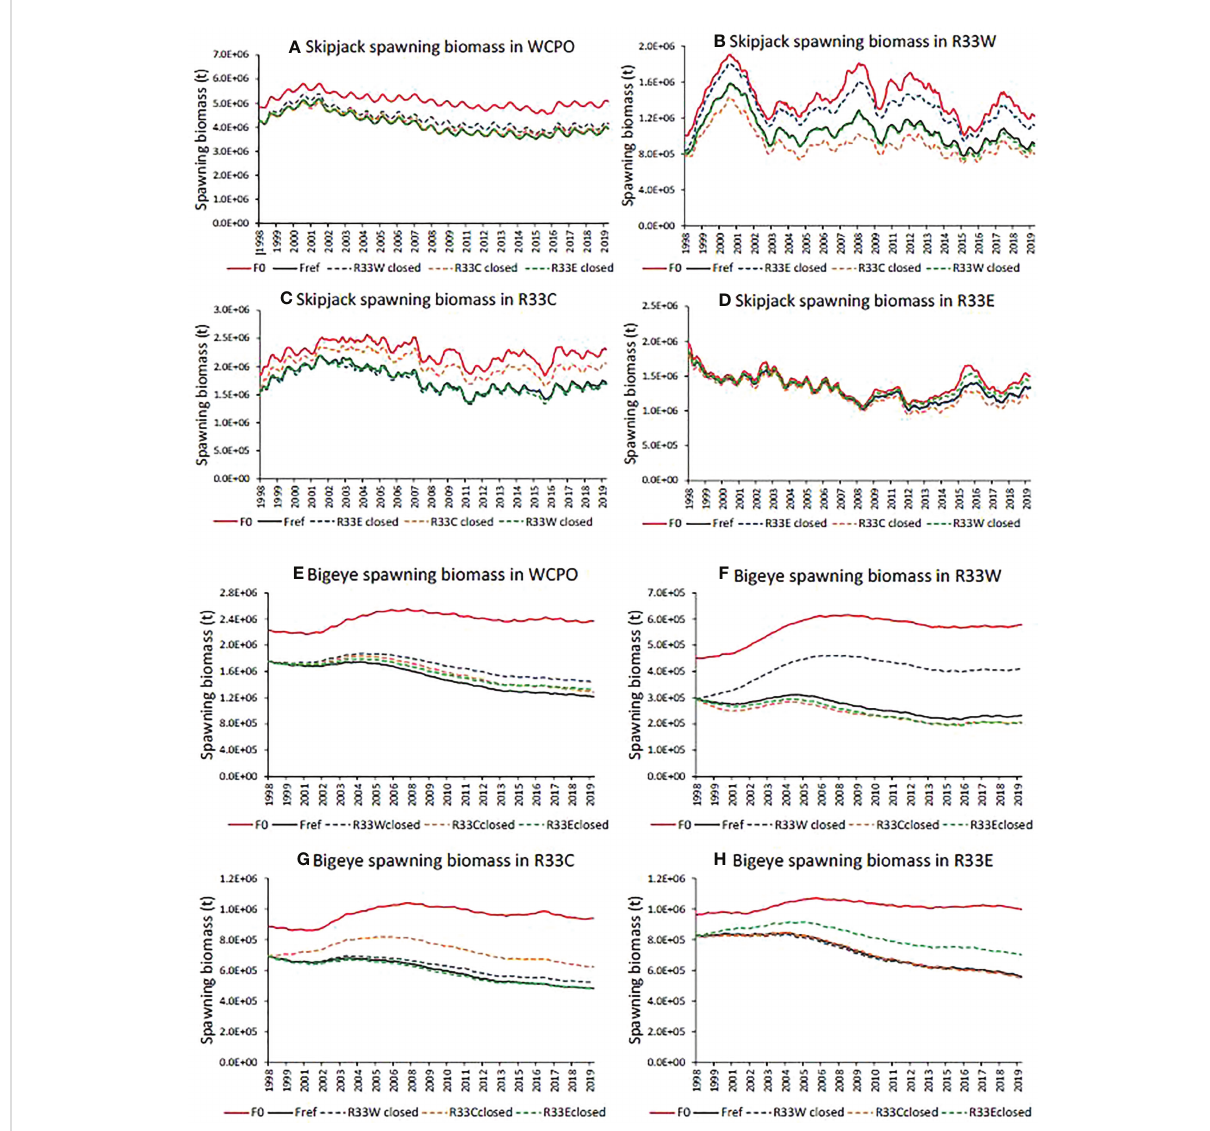
FIGURE 7 Time series of estimated skipjack (A-D) and bigeye (E-H) tuna spawning biomass in the absence of fi shing (F0), under the observed fi shing activity (Fref) and for retrospective large closures of approximately 33% of the western and central Paci fi c Ocean (WCPO) in the west (R33W), central (R33C) and eastern areas (R33E) compiled for the WCPO (A, E) , R33W (B, F) , R33C (C, G) and R33E (D, H) . See Figure 1 for a description of the